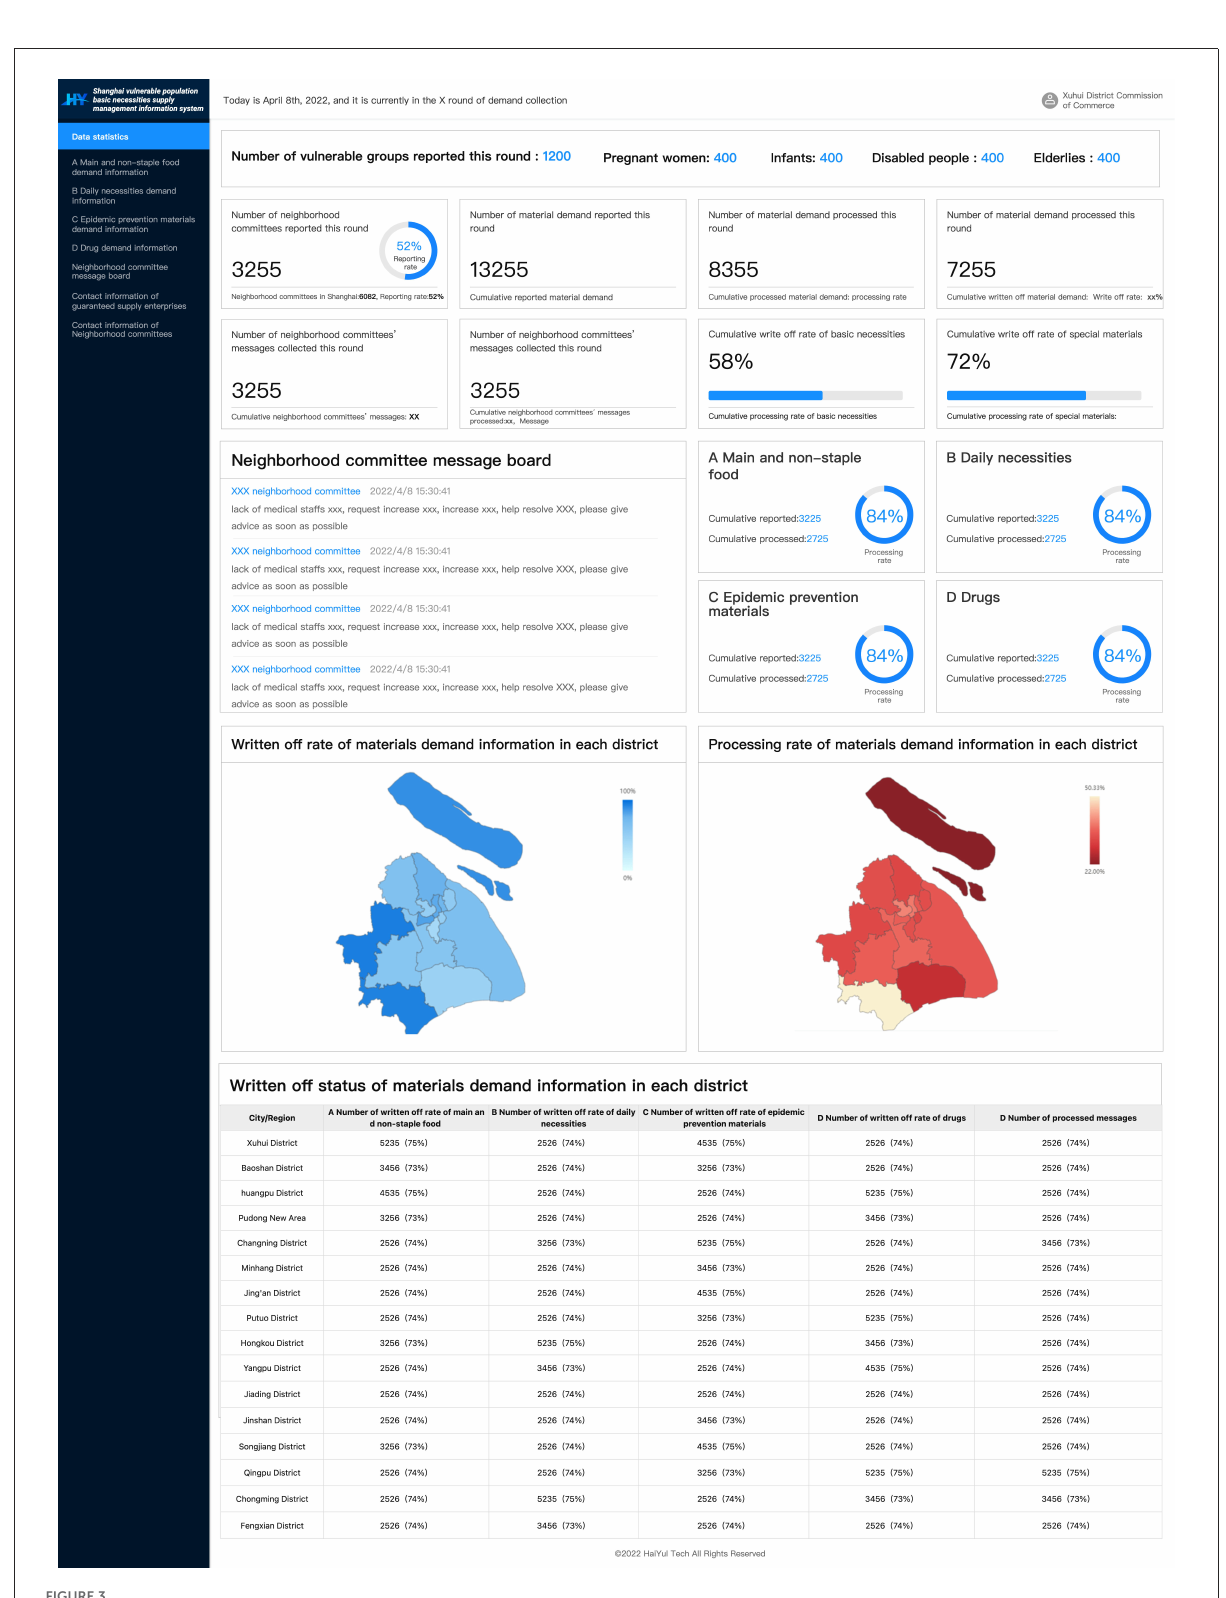
FIGURE3 Illustration of the system homepage (part of the dashboard showing demand and distribution data) used by the government.